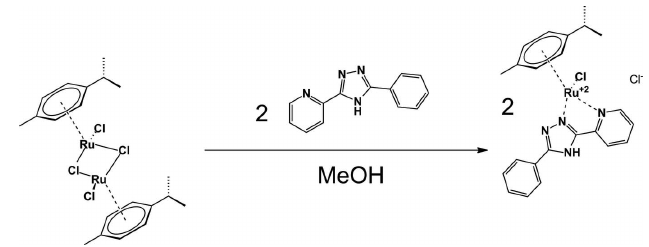
Figure 3 Synthesis of the title compound.